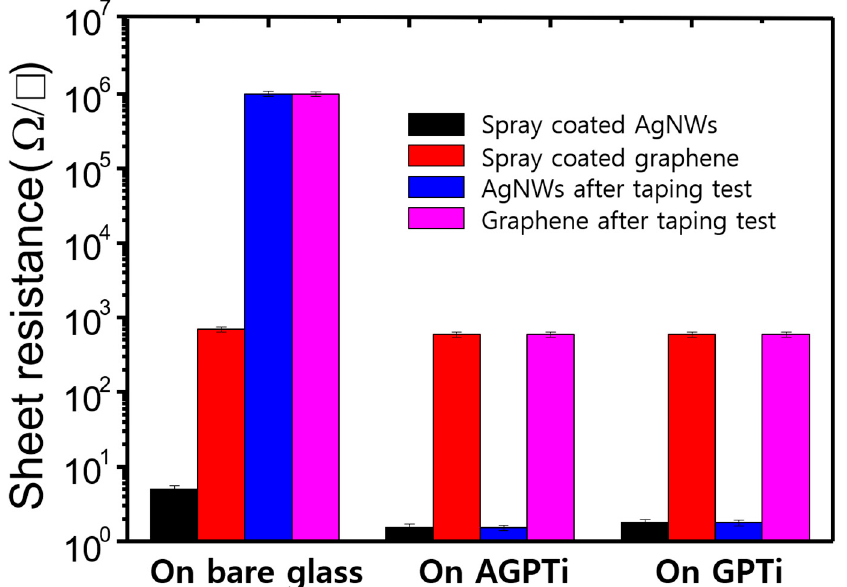
Figure 4. Changes in the sheet resistances of the AgNWs and graphene after the taping tests on the bare glass and AGPTi- and GPTi-coated glasses.